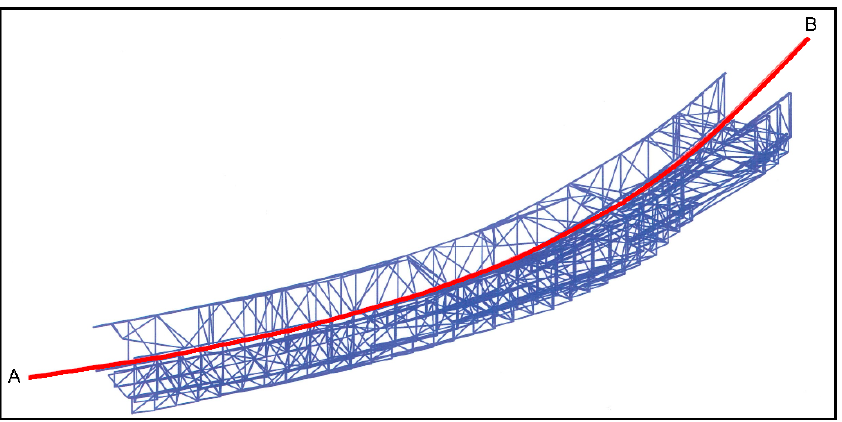
Figure 14. Output from Computer Simulations—3D trace of transported load.